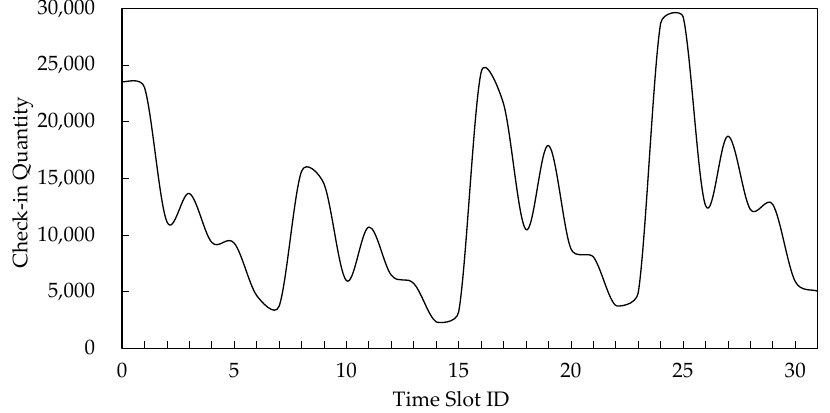
Figure 10. The distribution of check-ins for 32 time slots.